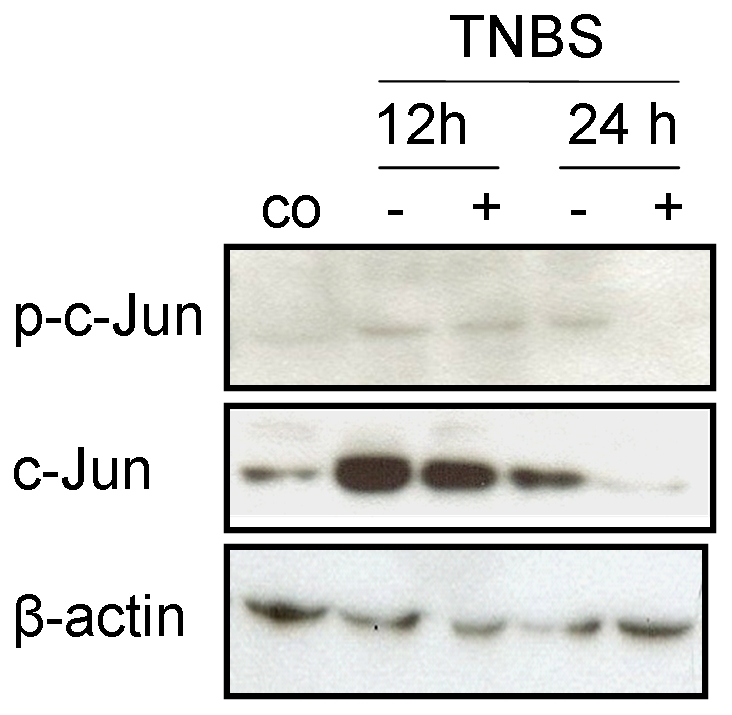
c-Jun and phospho-c-Jun.Western blot analysis of c-Jun and phospho-c-Jun in colon homogenates from untreated controls (co) and 12 h or 24 h following trinitrobenzene sulfonic acid (TNBS) administration without or with XG-102 (100 µg/kg sc.). These blots are representative of 3 independent experiments.